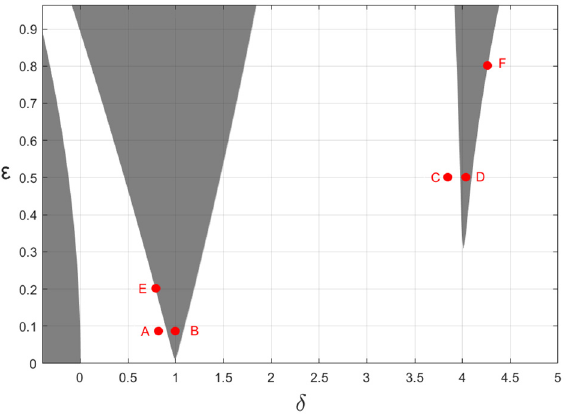
Figure 2. Stability chart of system (4), marked with the positions of randomly selected points A-F.